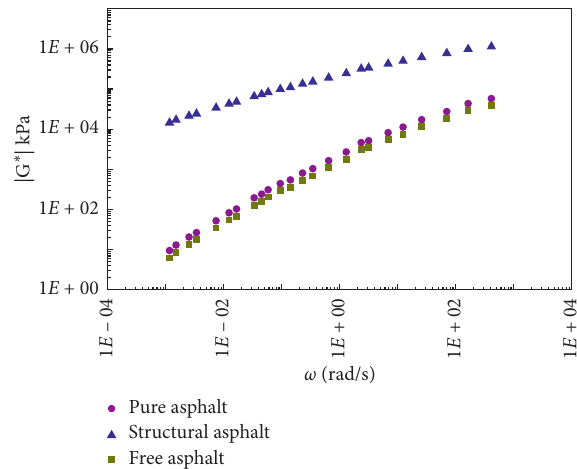
Figure 6: Dynamic shear modulus of structural asphalt and free